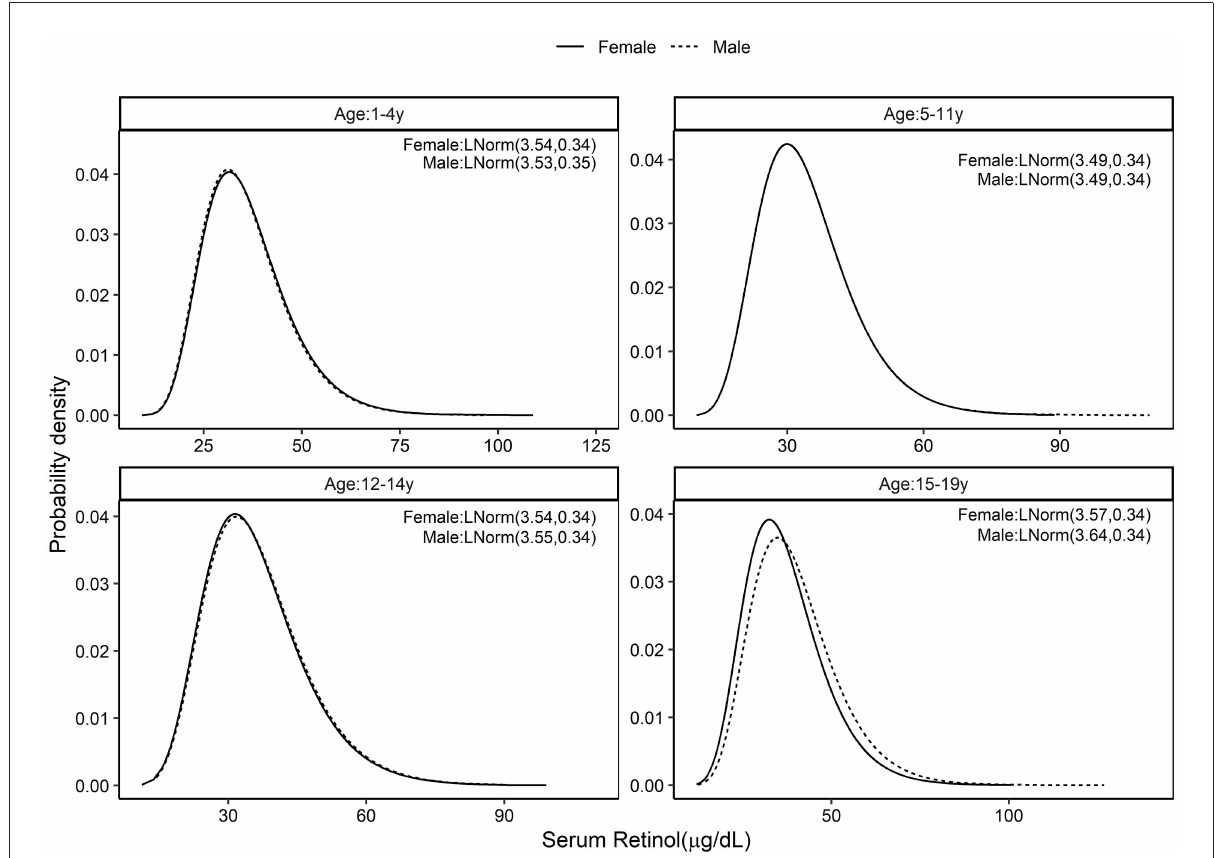
FIGURE1 Standard distribution of serum retinol ( µ g / dL ) concentrations among healthy Indian children aged 1–4, 5–11, 12–14, and 15–19 years; Solid line represents Female children and dotted line represents Male children. Values given in parenthesis are location and scale parameters of the lognormal distribution of serum retinol in µ g / dL